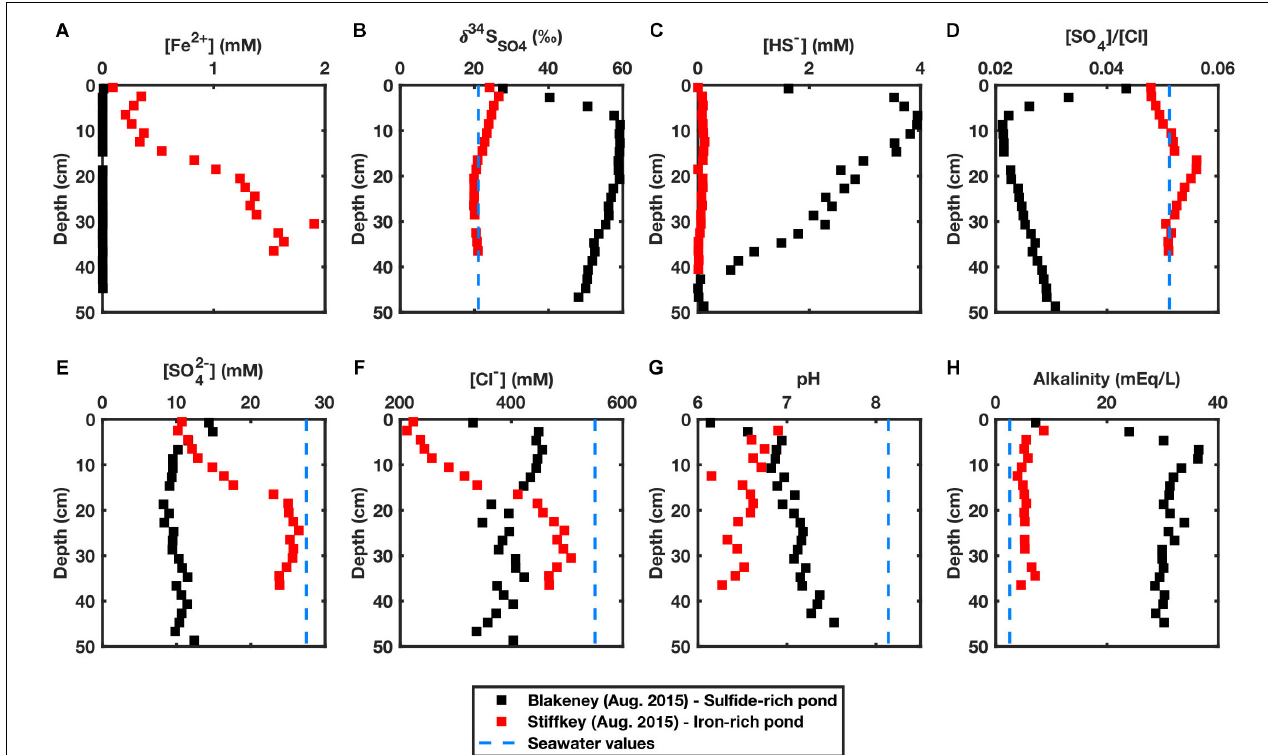
FIGURE 3 | Geochemical characteristics of porewater extracted from an iron-rich core from Stiffkey in August 2015 (shown in red) and a sulfide-rich core from Blakeney in August 2015 (shown in black). (A) Aqueous Fe(II) concentrations (mM) (B) δ 34 S SO4 ( (E) Aqueous sulfate concentrations (mM) (F) Aqueous chloride concentrations (mM) (G) pH values (H) Alkalinity (mEq/L). Dashed blue lines represent typical seawater values (seawater concentrations of Fe 2 + and HS − are